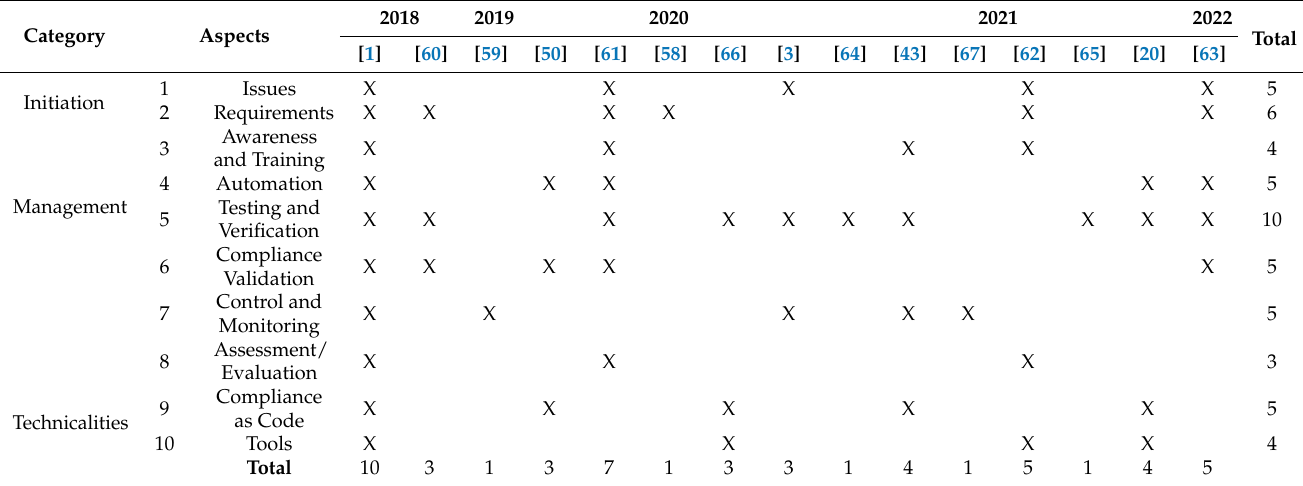
Table 4. Overview of Compliance Aspects by